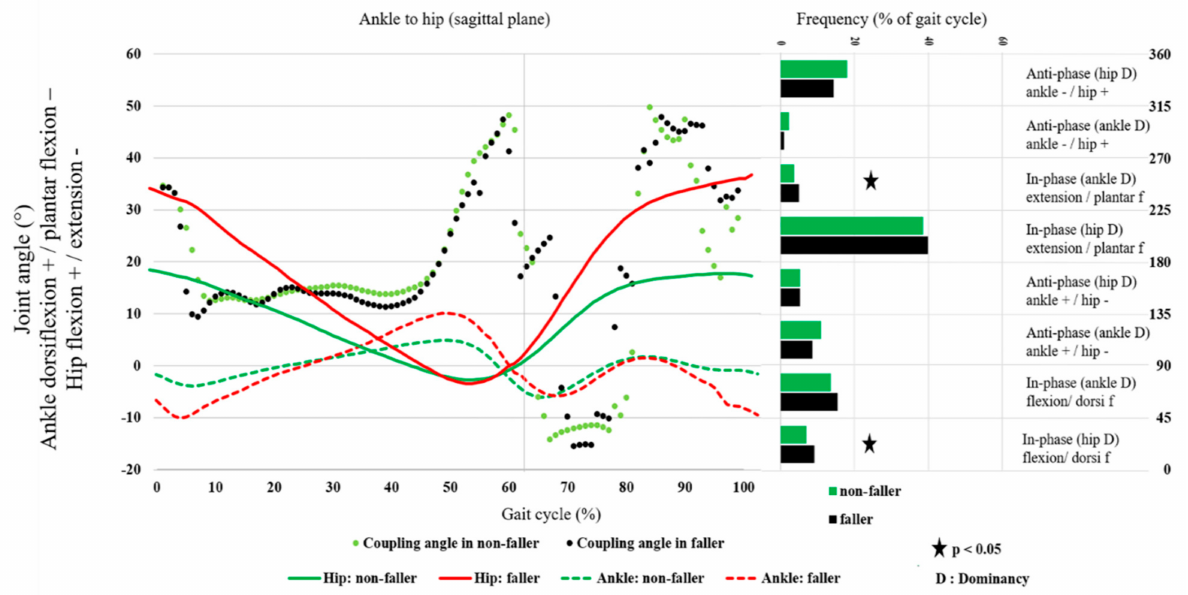
Figure 3. Ankle-to-hip angular displacement diagram (left axis), and frequency of coordination patterns (left axis) in the sagittal plane in fallers and non-fallers. The red and green solid lines are angular displacement of knee joint in fallers and non-fallers, respectively. The red and green dashed lines are angular displacement of ankle joint in fallers and non-fallers, respectively. The black and green dots are the frequency scatter of coupling angle in fallers and non-fallers, respectively. The black and green bar charts are the frequency percentage of coupling angle in gait cycle in fallers and non-fallers, respectively.